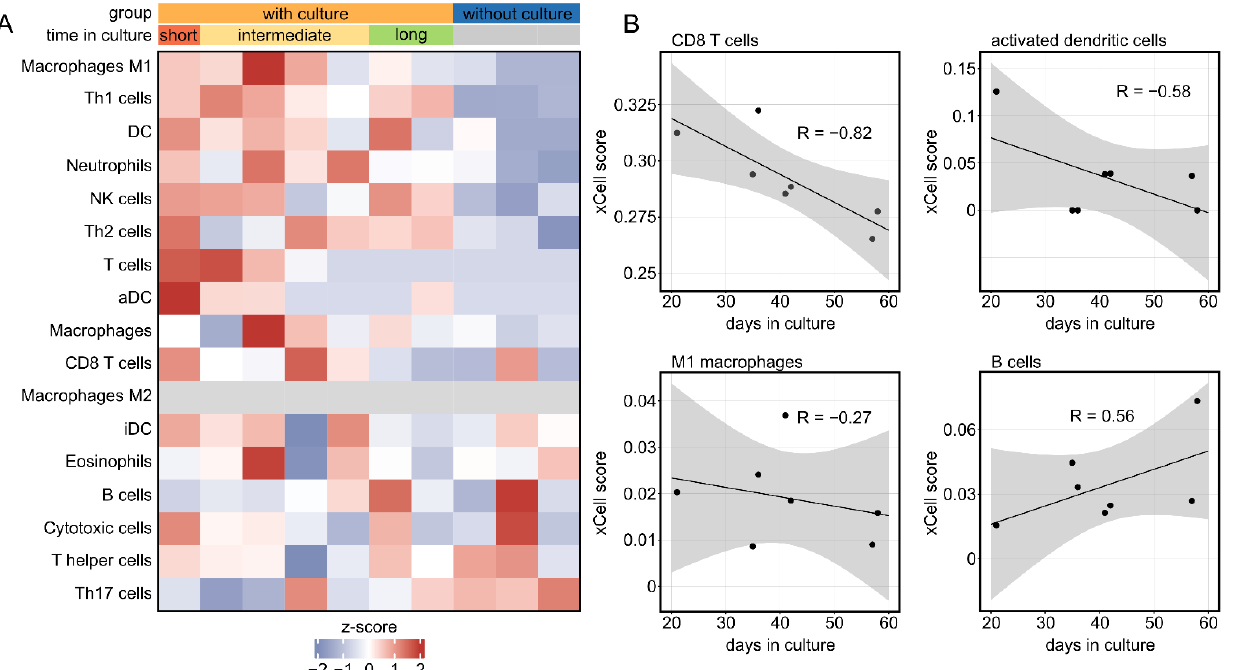
Figure 4. The corneal immune cell profile significantly changes in tissue culture in a time-dependent manner. ( A ): Immune cell profile of cultured human corneas characterized by cell-type enrichment analysis using xCell. The tool uses gene expression profiles of several immune cell types to calculate cell type enrichment scores. Each row represents one cell type, and each column represents one sample. The analysis revealed a significant influence of the culture in a time-dependent manner. Time in culture: short, 21 days; intermediate, 35 – 42 days; long, 56 – 57 days. ( B ): The influence of time in culture on the immune cell profile is illustrated by four immune cell populations.